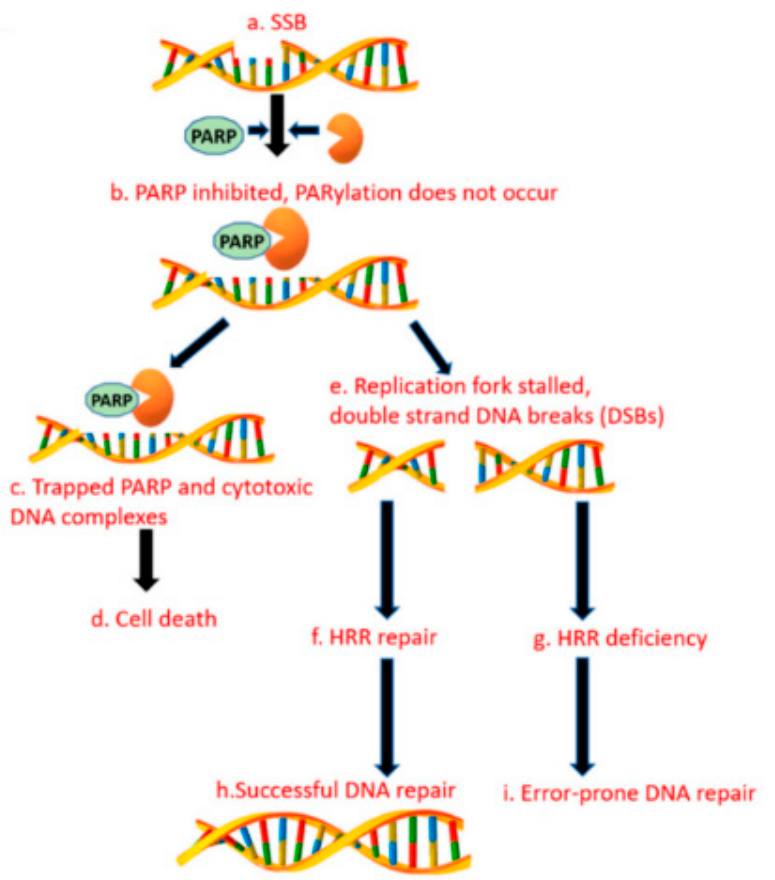
Figure 1. PARP enzyme inhibitors cause synthetic lethality in cancer cells with DNA repair defects or homologous repair defects.